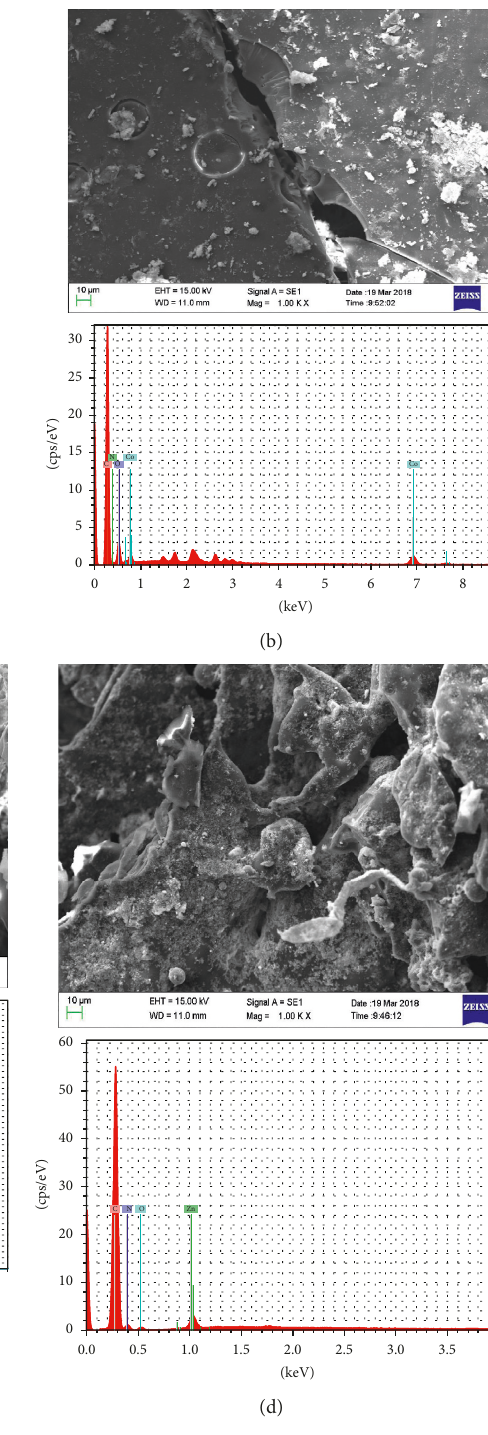
Figure 6: SEM images and SEM-EDX measurements of (a) poly(DEAMSt0.49-co-BMA), (b) poly(DEAMSt0.49-co-BMA)-Co, (c) pol- y(DEAMSt0.49-co-BMA)-Ni, and (d)